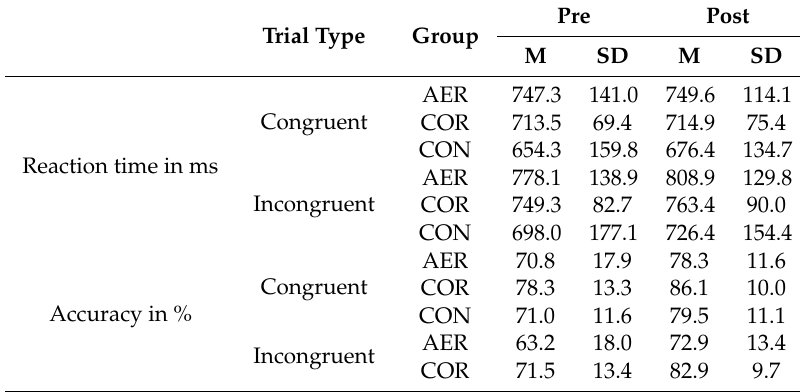
Table 3. Behavioral performance on the Flanker task at pre- and post-test displayed for each group.